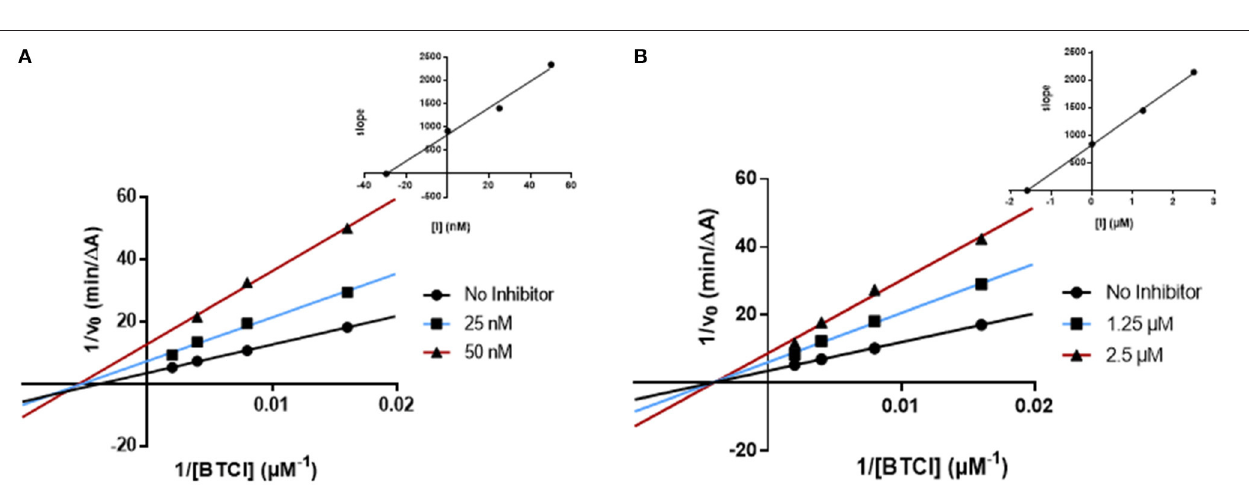
FIGURE 4 | Kinetic studies on the mechanism of AChE inhibition by compounds and (A) 18, and (B) donepezil. The effect of the inhibitors on the enzyme was determined from the double reciprocal plot of 1/rate (1/V) vs. 1/substrate concentration in presence of varying concentrations of the inhibitors. The Ki values were calculated by the intersection of the curves obtained by plotting 1/V vs. the inhibitor concentration for each substrate concentration (Dixon plots insets on the top right).